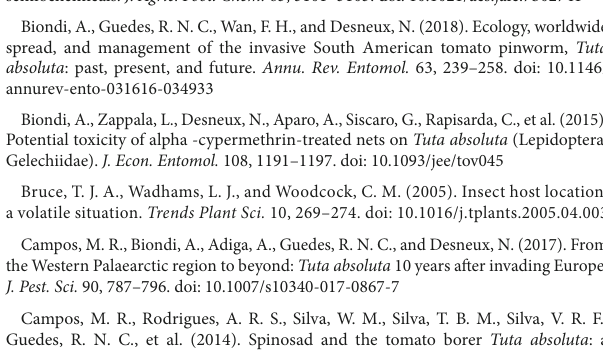
SUPPLEMENTARY FIGURE S1 Electroantennographic (EAG) responses of T. absoluta males to 20 volatile compounds. The bar represents the standard error, and the different letters above each bar indicate Turkey’s highest significant difference at p < 0.05. SUPPLEMENTARY FIGURE S2 Responses of male T. absoluta to nine VOCs in a Y-type olfactometer. NS indicates no significant difference; asterisks indicate significant differences (* p < 0.05; ** p <